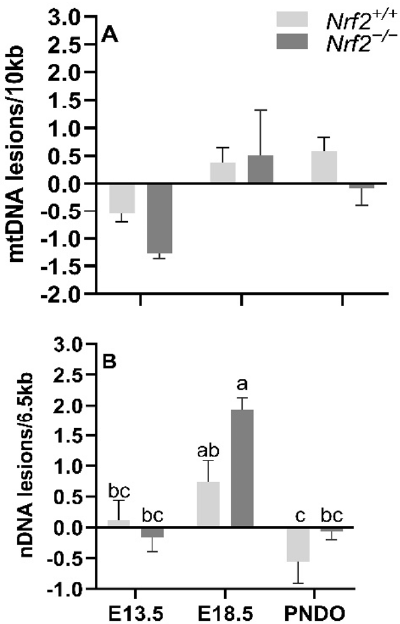
Figure 2. Effect of Nrf2 deletion on lung DNA lesions during embryonic development and at birth. Lesions in mitochondrial (mtDNA, ( A ) and nuclear DNA (nDNA, ( B ) were determined in wild-type ( Nrf2 +/+ ) and Nrf2 -deficient ( Nrf2 − / − ) mouse lungs at embryonic (E) days 13.5 and 18.5 or postnatal day 0 (PND0, day of birth) using a gene-specific qPCR assay (lesions per 10 Kb for mtDNA or per 6.5 kb for nDNA). Nrf2 +/+ Mean ± S.E.M. presented ( n = 5–6/group). A two-way ANOVA was employed with age (E13.5, E18.5, PND0) and genotype ( Nrf2 +/+ , Nrf2 − / − ) as the factors. Letters were used when there were significant main effects ( p < 0.05). Bars not connected by the same letter are significantly different ( p < 0.05).